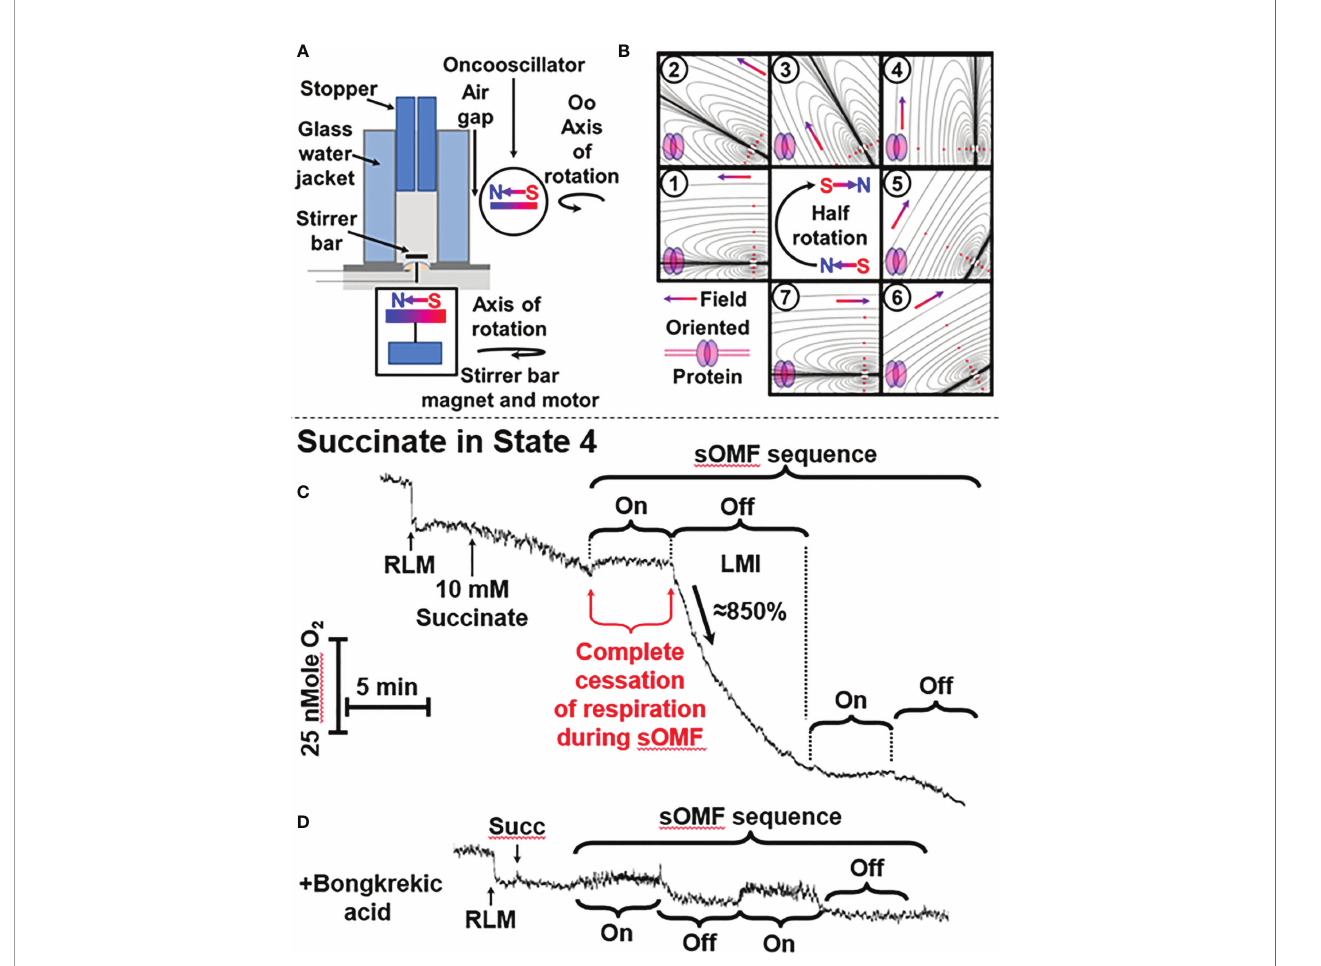
FIGURE 1 | sOMF treatment causes the loss of mitochondrial integrity in State 4 RLM. (A) Diagrammatic representation of O 2 electrode and oncoscillator. (B) Diagrammatic representation of the change in the direction of magnetic fi eld orientation and lines of force during a half rotation of an oncoscillator. (C) Isolated RLM, respiring on succinate under state 4 conditions, undergo a loss mitochondrial integrity (LMI) after being subjected to 5 min of sOMF stimulation. (D) Bongkrekic acid, which blocks the MPT, halts the